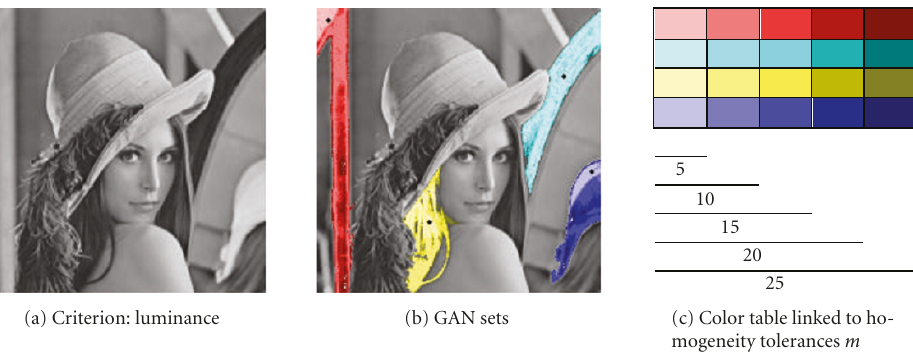
Figure 3: Nesting of GAN sets of four seed points (b) using the luminance criterion (a) and di ff erent homogeneity tolerances: m = 5,10,15,20, and 25 encoded by the color table (c). The GANs are nested with respect to m . Following the color table (c), a GAN set de- fined with a certain homogeneity tolerance m could be represented by several tinges of the color associated to its seed point. For instance, the GAN set of the point highlighted in the hairs of Lena for m = 25 is represented by all the points colored with all tinges of